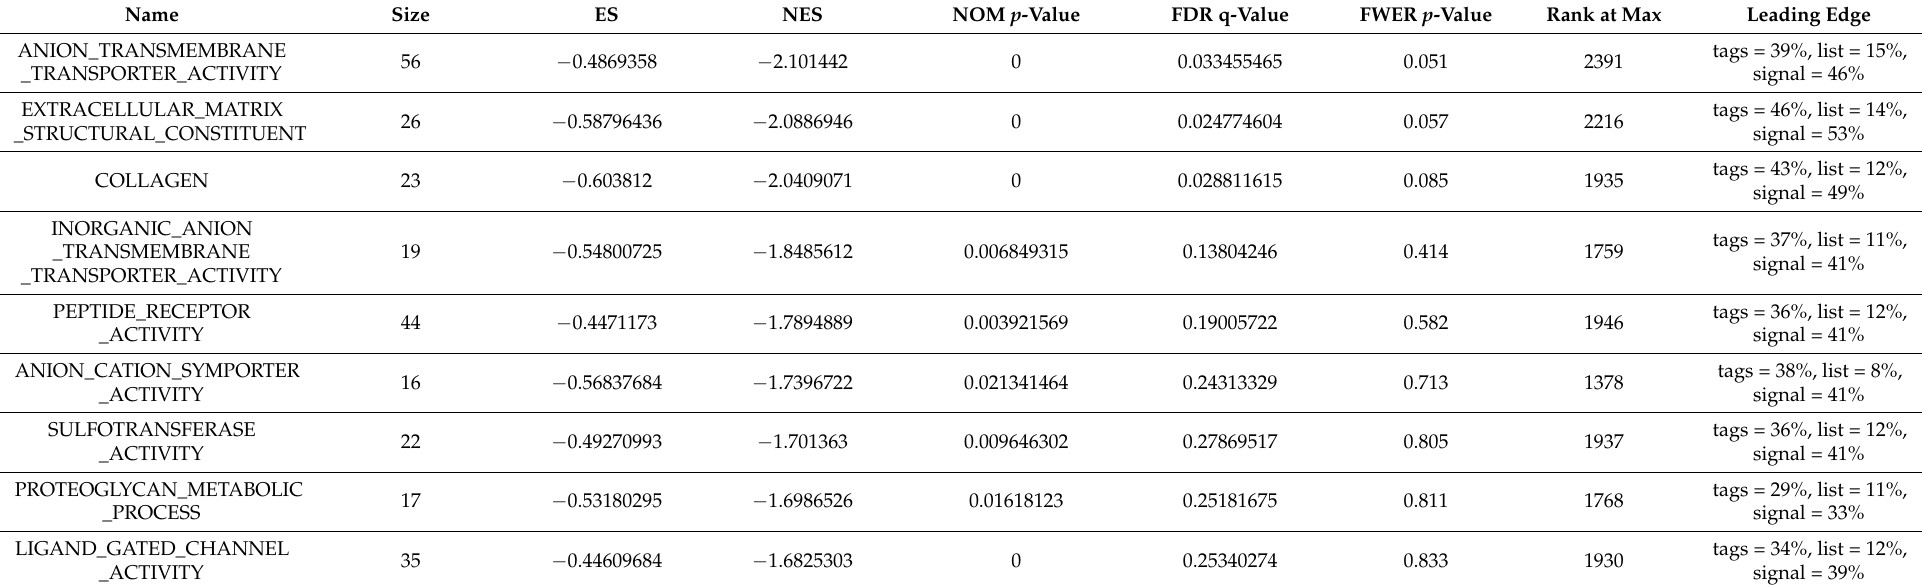
Table 1. Gene set enrichment analysis (GSEA). In all, 288 sets of genes were analyzed. Top 34 gene sets are shown. As seen, the highest gene set was associated with monooxygenase activity. ES: the number of genes in the gene set after filtering out those genes not in the expression dataset. NES: normalized enrichment score; that is, the enrichment score for the gene set after it has been normalized across analyzed gene sets. NOM p -value: nominal p value; that is, the statistical significance of the enrichment score. The nominal p -value is not adjusted for gene set size or multiple hypothesis testing; therefore, it is of limited use in comparing gene sets. FDR q-value: false discovery rate; that is, the estimated probability that the normalized enrichment score represents a false positive finding. FWER p -value: family wise-error rate; that is, a more conservatively estimated probability that the normalized enrichment score represents a false positive finding. As the goal of GSEA is to generate hypotheses, the GSEA team recommends focusing on the FDR statistic. RANK AT MAX: the position in the ranked list at which the maximum enrichment score occurred. The more interesting gene sets achieve the maximum enrichment score near the top or bottom of the ranked list; that is, the rank at max is either very small or very large. LEADING EDGE: displays the three statistics used to define the leading-edge subset. Tags: the percentage of gene hits before (for positive ES) or after (for negative ES) the peak in the running enrichment score. This indicates the percentage of genes that contributed to the enrichment score. List: the percentage of genes in the ranked gene list before (for positive ES) or after (for negative ES) the peak in the running enrichment score. This indicates that the enrichment score is attained in the list. Signal: the enrichment signal strength that combines the two previous statistics: (Tag %) (1 – Gene %) (N/(N-Nh), where N is the number of genes in the list and Nh is the number of genes in the gene set. If the gene set is entirely within the first Nh positions in the list, then the signal strength is maximal or 100%. If the gene set is spread throughout the list, the signal strength decreases to 0%. These statistics describe the leading-edge subset of a single gene set. Leading edge analysis was used to analyze the overlap between multiple leading-edge